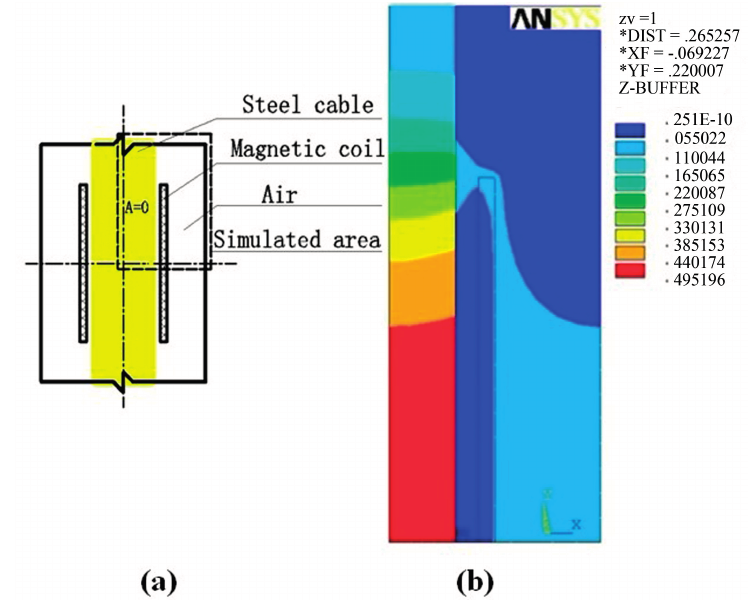
Figure 5. Finite element simulation: (a) Geometrical graph; and (b) The simulation result of one case. A denotes the magnetic vector